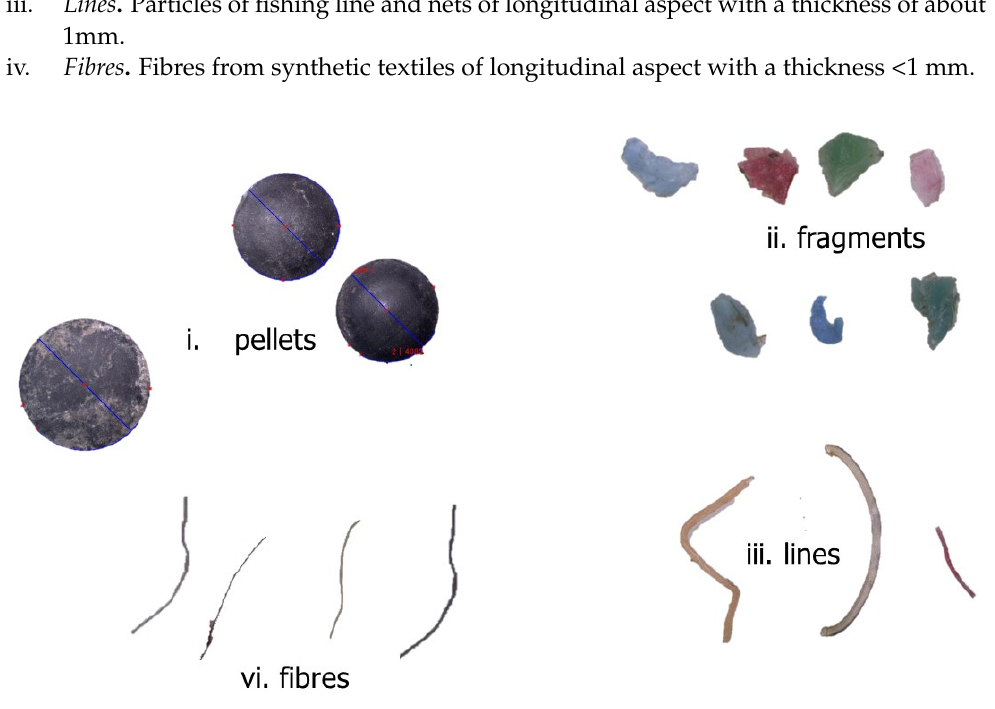
Figure 4. Types of microplastic morphologies identified for the automatic classification.